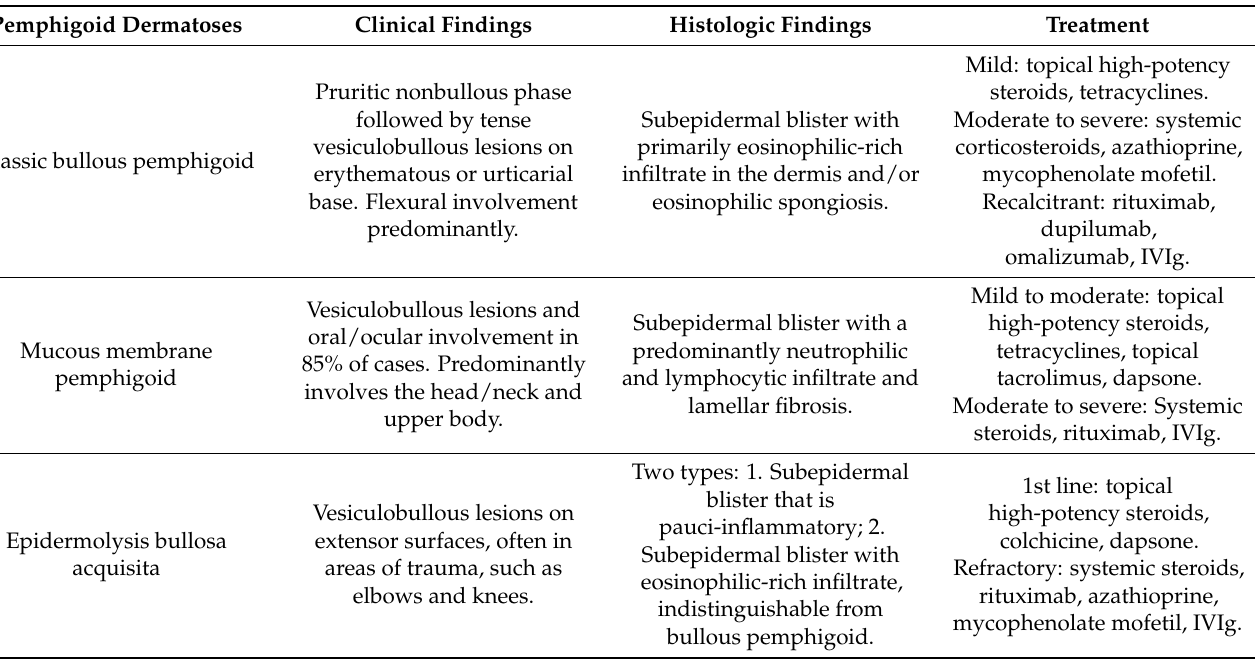
Table 1. Summary of clinical and histopathologic findings and treatment of pemphigoid dermatoses. Pemphigoid